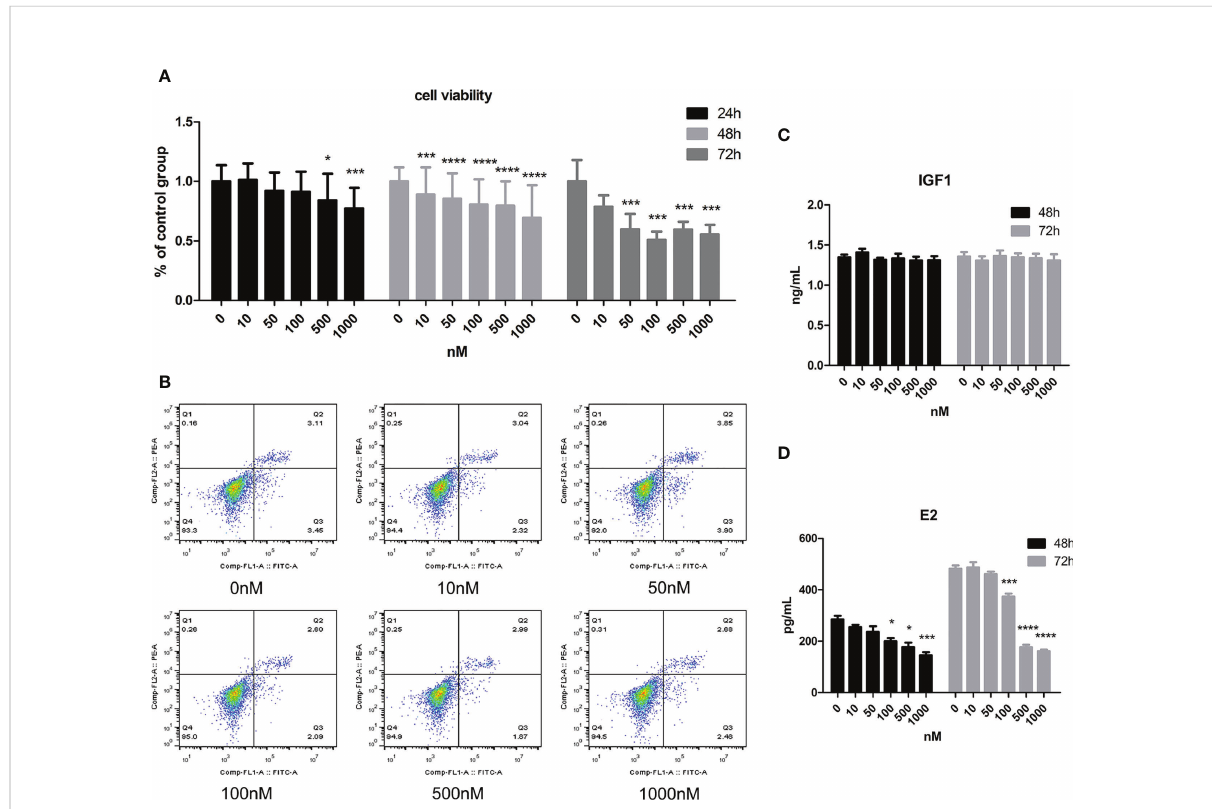
FIGURE 2 The impact of CORT at different doses on cell viability, apoptosis, E2 secretion, and IGF1 secretion. KGN cells were treated with solvent or 10, 50, 100, 500, and 1,000 nM CORT, respectively. Cell viability was assessed at 24, 48, and 72 h by the CCK-8 method. n ≥ 17 in each group at each time point; one-way ANOVA. (A) Cell apoptosis was determined at 72 h by fl ow cytometry. n = 3 with two repeats in each assay; one-way ANOVA. (B) IGF1 (C) and E2 (D) concentrations were determined by ELISA after treatment for 48 and 72 h n = 3 with one repeat in each assay; one-way ANOVA. *P < 0.05, ***P < 0.001, ****P < 0.0001 compared to group “ 0.